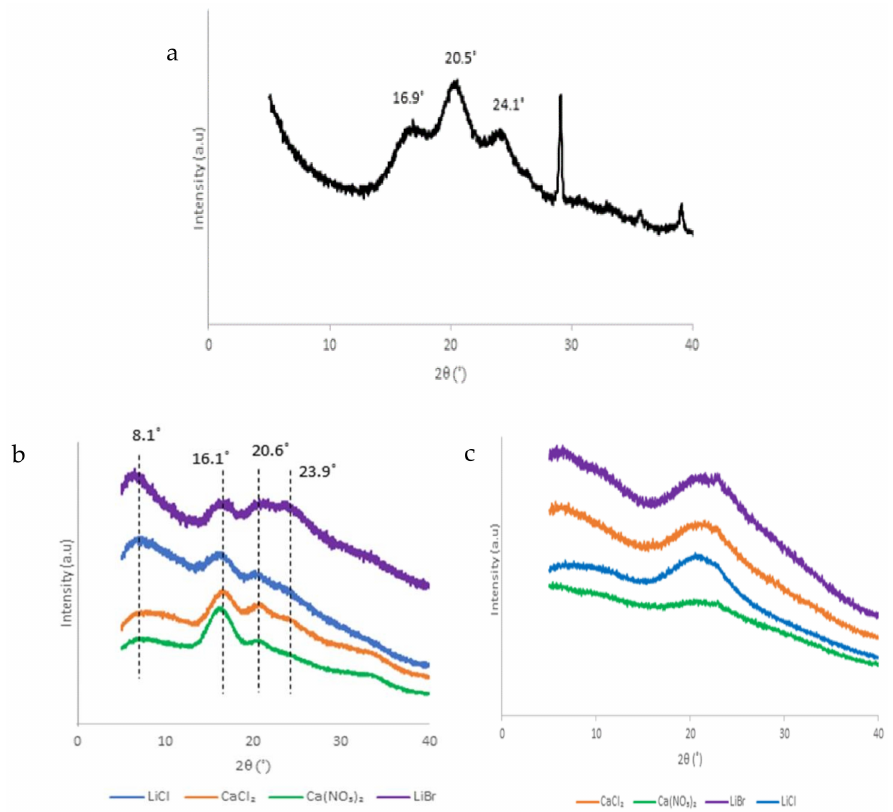
Figure 17. XRD diffractograms of ( a ) degummed SF, ( b ) films, and ( c )